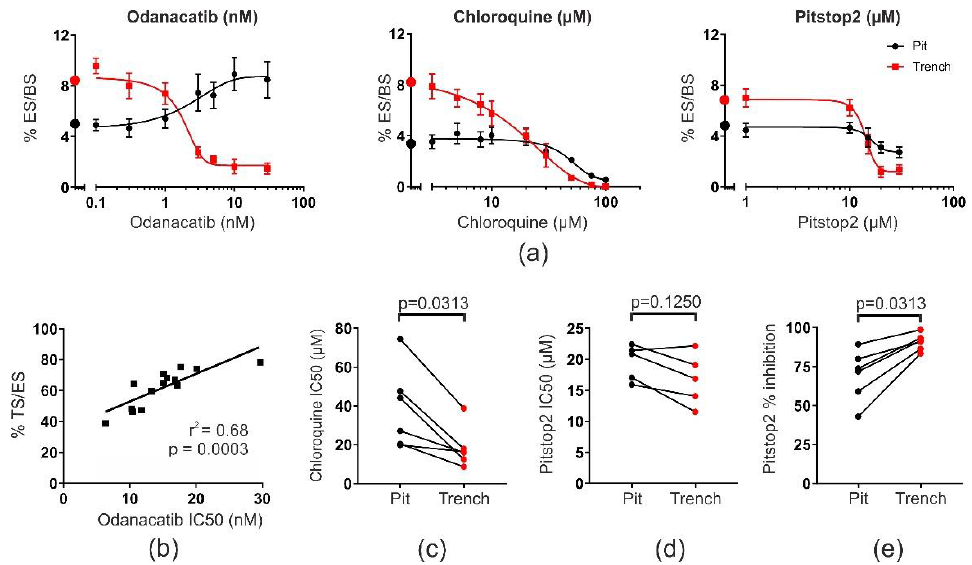
Figure 1. Di ff erent susceptibilities of pit- and trench-resorbing OCs to distinct types of inhibitors. ( a ) Representative dose–response curves of bone resorption upon treatment with three di ff erent inhibitors. Bone resorption is categorized into pit (black) and trench (red) surface per bone surface. Baseline levels are indicated by black and red circles on the y-axis, respectively. Data represent the results from a single experiment using OCs from a single donor (but di ff erent for each drug) and with n = 5 bone slices for each condition tested. %ES / BS, percent eroded surface per bone surface. Error bars represent SD. ( b ) Linear correlation between the mean trench surface per eroded surface (% TS / ES) (calculated from n = 5 bone slices) in control conditions and the respective IC50 (determined by curve fits as shown for odanacatib in (a)) of odanacatib determined in OC cultures from 14 di ff erent donors (each experiment was performed as shown in (a)). ( c ) Comparison of IC50-values obtained from six di ff erent experiments (using di ff erent donors) determined for pit surface per bone surface (black) and trench surface per bone surface (red). Data obtained from the same experiment are connected with a line. Each IC50 was determined from individual experiments based on curve fits as shown for chloroquine in (a). Statistics: Wilcoxon paired test. ( d ) Comparison of pit and trench IC50 values obtained from five di ff erent experiments (using di ff erent donors) after treatment with Pitstop2. Data obtained from the same experiment are connected with a line. Each IC50 was determined from individual experiments based on curve fits as shown for Pitstop2 in (a). Statistics: Wilcoxon paired test, n = 5. ( e ) Comparison of percentwise inhibition at the highest dose of Pitstop2 with respect to pit and trench surfaces obtained from six di ff erent experiments (using di ff erent donors). Data obtained from the same experiment are connected with a line. Each level of inhibition was determined from individual experiments based on curve fits as shown for Pitstop2 in (a). Statistics: Wilcoxon paired test.